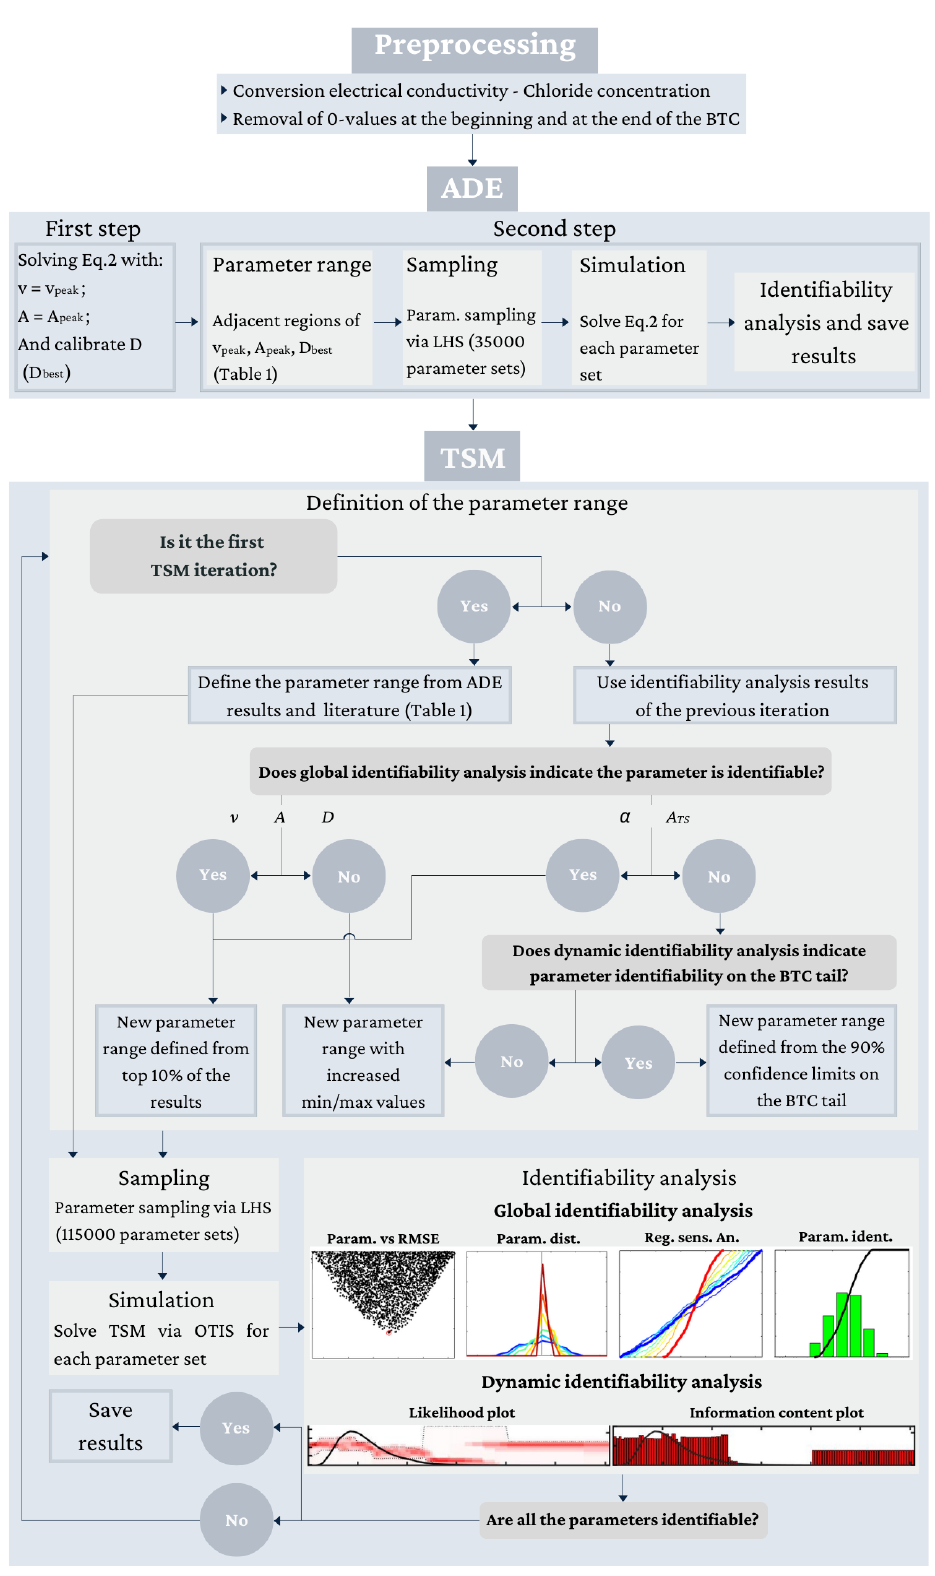
Figure 1. Conceptual modelling workflow. The parameters have the following unit of measurement: velocity v (ms − 1 ), cross-sectional area A (m 2 ), longitudinal dispersion coefficient D (m 2 s − 1 ), exchange coefficient α (Ls − 1 ), and area of the transient storage zone A TS (m 2 ).